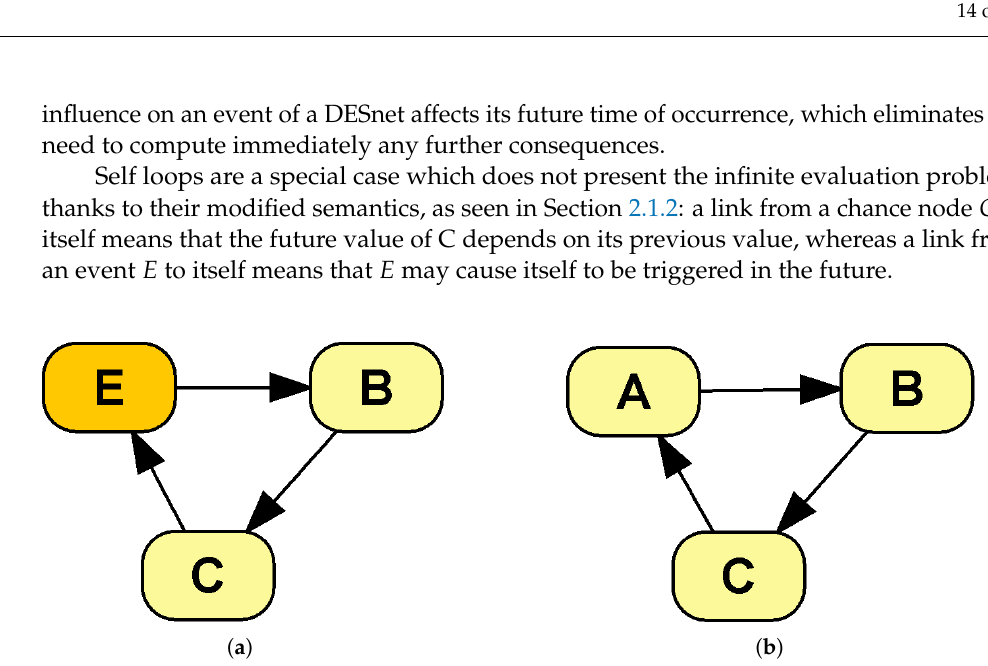
Figure A1. Cycles in a DESnet: ( a ) is allowed because it contains an event node, whereas ( b ) is